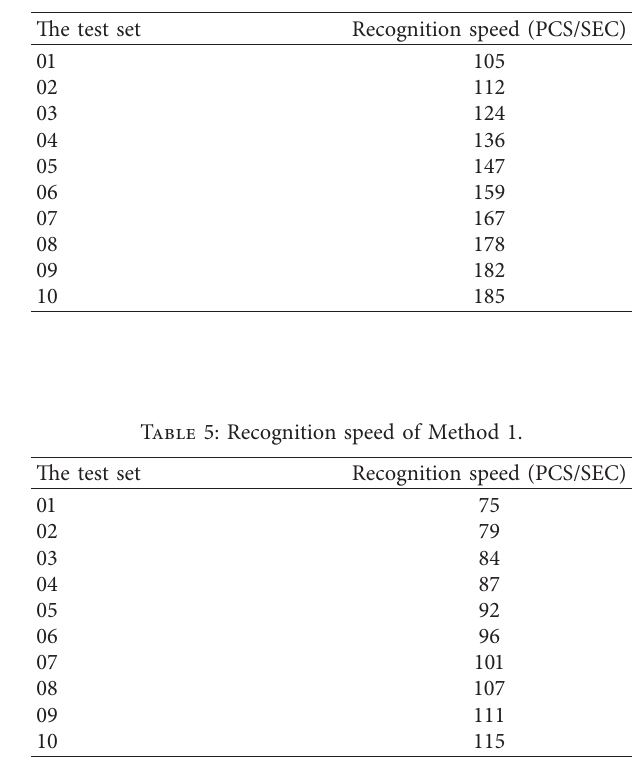
Table 4: The recognition speed of the proposed method.